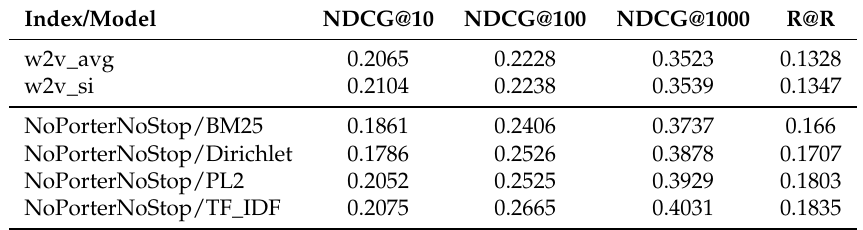
Table 10. T2: scores of NDCG and R@R of w2v runs and Terrier with NoPorterNoStop